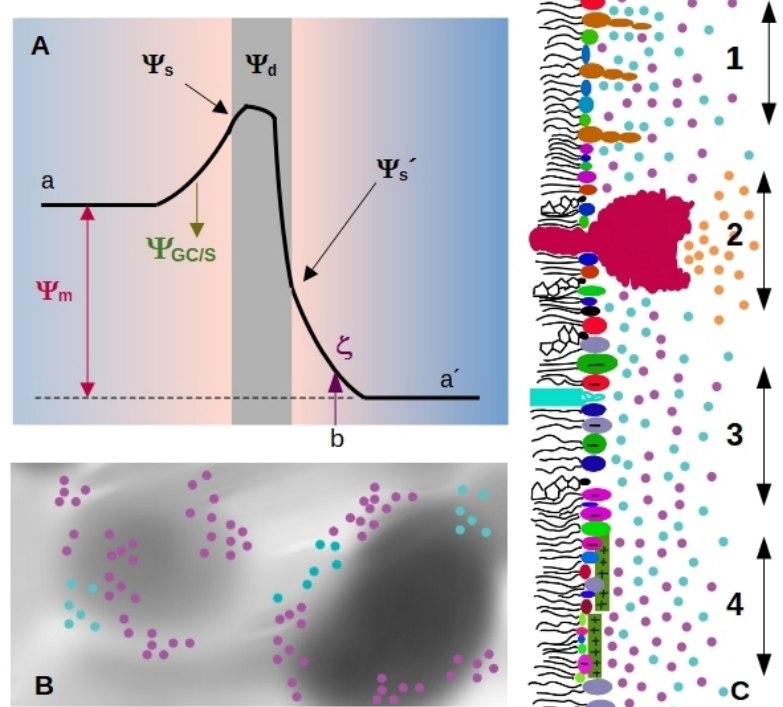
Figure 1. Scheme illustrating membrane electrostatics. ( A ) Electrostatic potential profiles that bear a membrane (gray region) along the normal axis. Volta potentials are usually different on each side of the membrane, the difference between the value on the left (a) and right (a’) side corresponds to the membrane potential Ψ m . Charged species on the membrane generate the surface potential Ψ s . The charged membrane induce an ion cloud and a potential drop characterized through Gouy- Chapman or Stern model Ψ GC / S . In the scheme, the slipping plane is at a distance b from the membrane, and the potential value at this point corresponds to the zeta potential ζ . Membranes are composed of multipoles organized in an ordered array, generating the dipole potential Ψ d . ( B ) Possible charge distribution in the membrane plane with non-homogeneous electrical properties. Gray levels indicate different values for the dielectric constant. Cyan circles represent cations and pink circles, anions. ( C ) Lateral view of a membrane hemilayer, where different situations coexist. As in B, cyan circles represent cations and pink circles, anions. 1—Gangliosides protrude from the plane formed by the polar head groups of less bulky lipids, generating a rough surface. 2—A pump or a channel generates a local ion gradient (orange circles correspond to protons, sodium, calcium or the specific ion that passes trough the pump/channel). 3—Region of the membrane enriched in anionic lipids. This region will attract cations. 4—cationic peptides adsorbed to a region of the membrane generate a positive surface that attracts